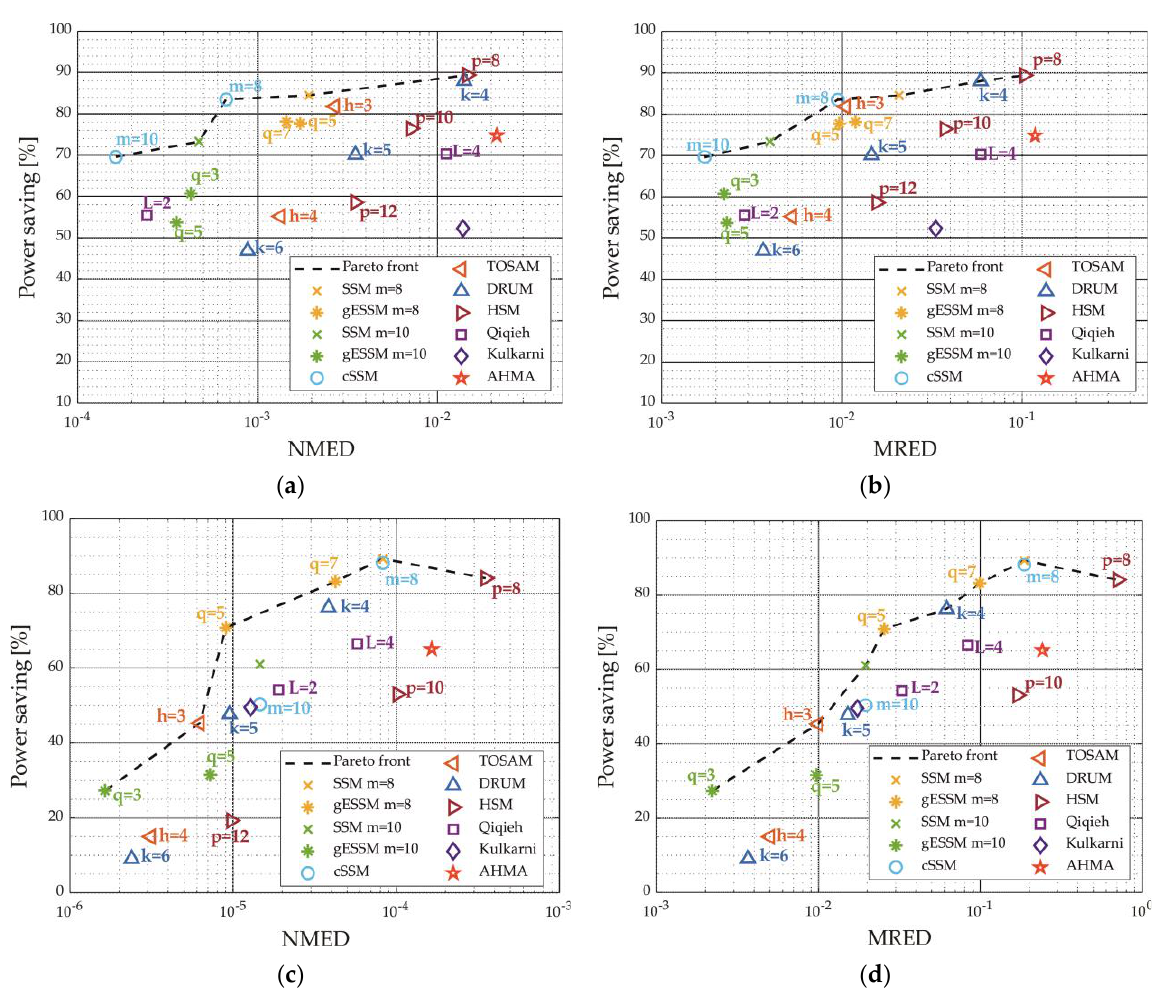
Figure 12. In the case of uniform distribution: ( a ) NMED vs. Power saving and ( b ) MRED vs. Power saving. In the case of half- normal distribution (σ = 2048): ( c ) NMED vs. Power saving and ( d ) MRED vs. Power saving.